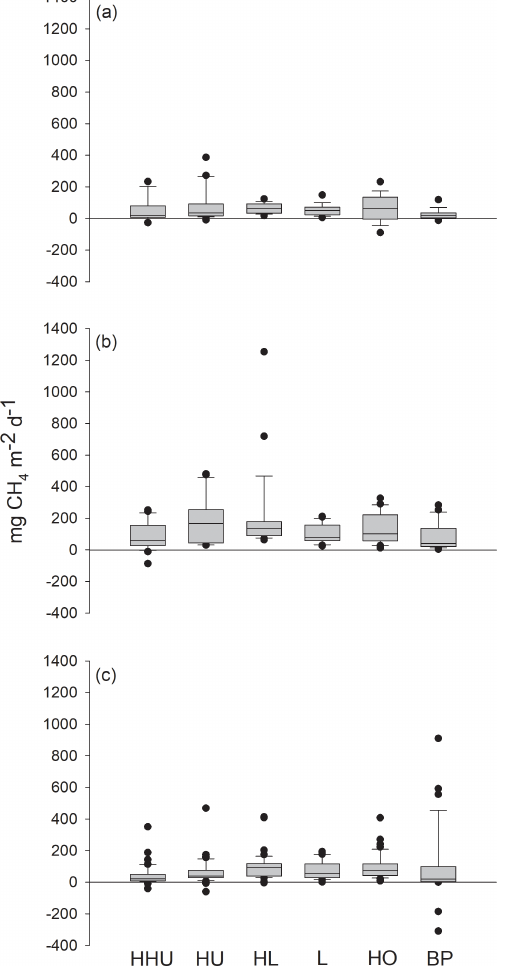
Figure 2. Methane fluxes in the Siikaneva bog in the three sub- sequent years (a) 2012, (b) 2013 and (c) 2014 from six different plant community types: high hummock (HHU), hummock (HU), high lawn (HL), lawn (L), hollow (HO) and bare peat surfaces (BP). tively (Fig. 2). Each year methane fluxes were generally or in autumn (Fig.